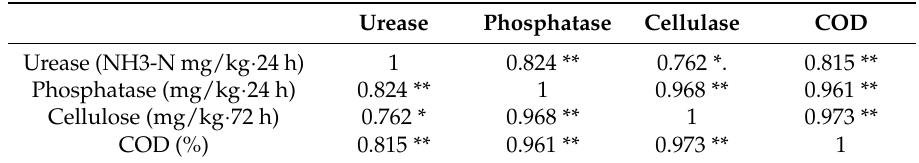
Table 2. Pearson correlation with COD removal efficiency and enzyme activity.